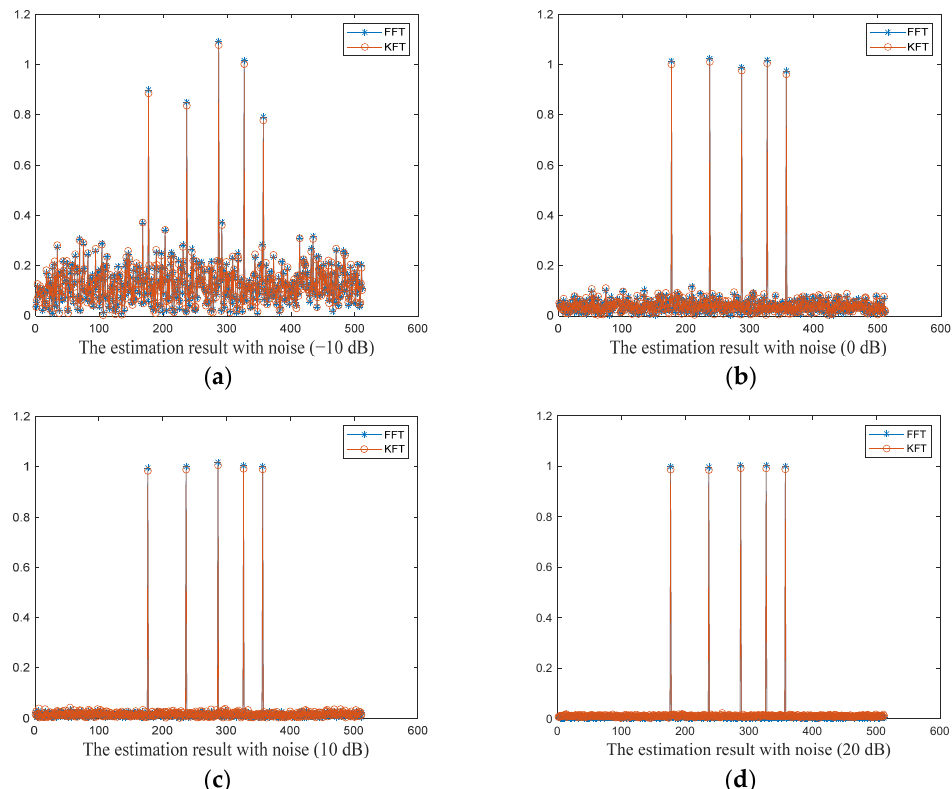
Figure 2. The simulation results of the Fourier transform and the proposed KF ‐ tracking algorithms for different SNR. Based on the principle of the KF ‐ tracking method (as analyzed in Section 3), the fre ‐ z is estimated and corrected at each iteration, which can make the quency separation of m state vector gradually getting focused. The corrected state vector at each iteration is demonstrated in Figure 3, where SNR is 10dB .